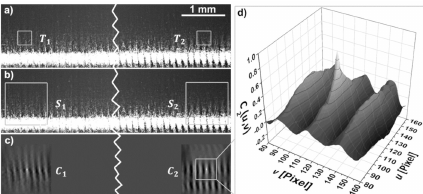
→ r k within the field-of-view.